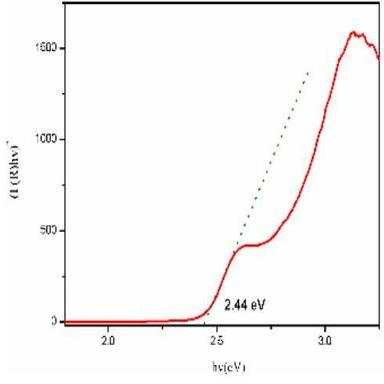
nd gap energy (Direct)